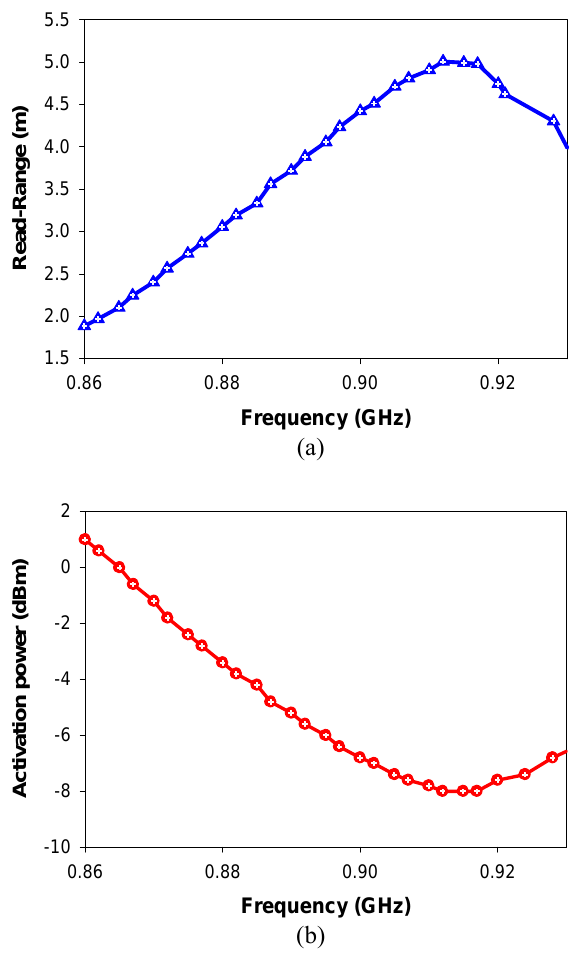
Figure 9: Activation power and Read range as a function of frequency: (a) Measured activation power, (b) Measured and simulated read range.